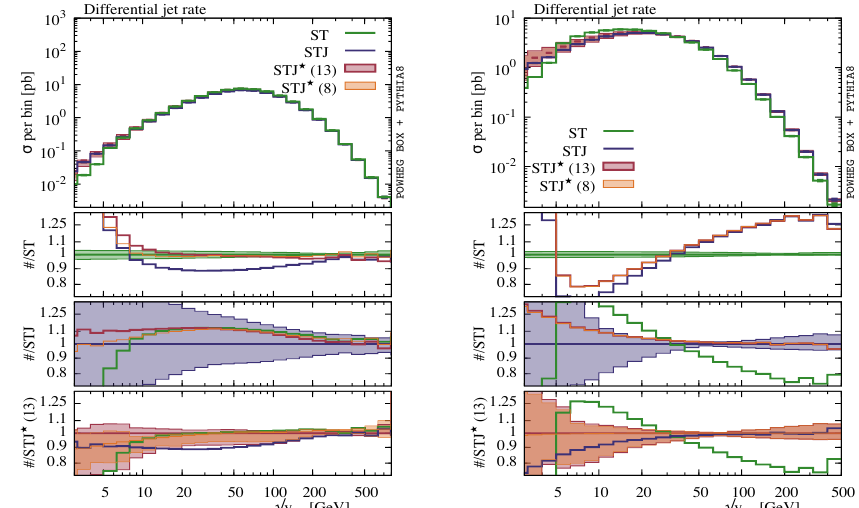
Figure 8 . 0 ! 1 (left) and 1 ! 2 (right) di(cid:11)erential jet rates in the k t clustering algorithm, at the 8 TeV LHC. As in (cid:12)gure 7, the STJ ? (13) program (red) uses a Minlo Sudakov form factor tuned using 13 TeV LHC ST and STJ samples, according to sections 2.4{2.5. The STJ ? (8) program analogously uses a Minlo Sudakov form factor tuned with 8 TeV LHC ST and STJ samples.